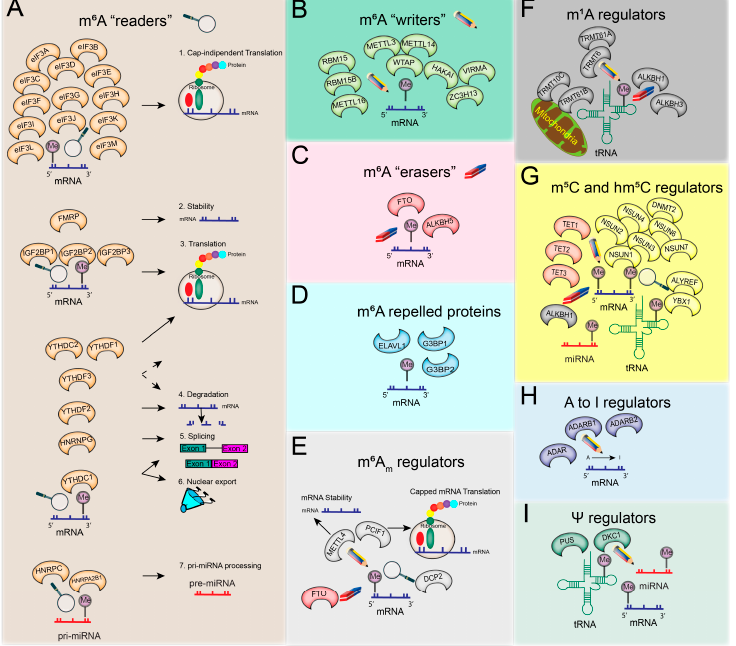
Figure 1. RNA modifications are mediated by known epitranscriptomic regulators: readers (magni- fying glass), writers (pencil), and erasers (rubber). The panels depict ( A ) m 6 A reader members with their roles in different aspects of RNA biology; ( B ) m 6 A writers; ( C ) m 6 A erasers; ( D ) proteins re- pelled by m 6 A methylation; ( E ) m 6 A m regulators and their known roles; ( F ) m 1 A regulators and their main role during tRNA and mitochondrial tRNA life; ( G ) m 5 C and hm 5 C regulators; ( H ) known adenosine-to-inosine (A–I) regulators; ( I ) Ψ regulators.